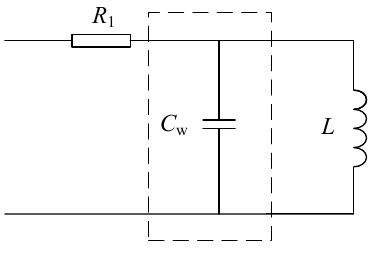
Figure 9. Equivalent circuit of resistance–inductance load.